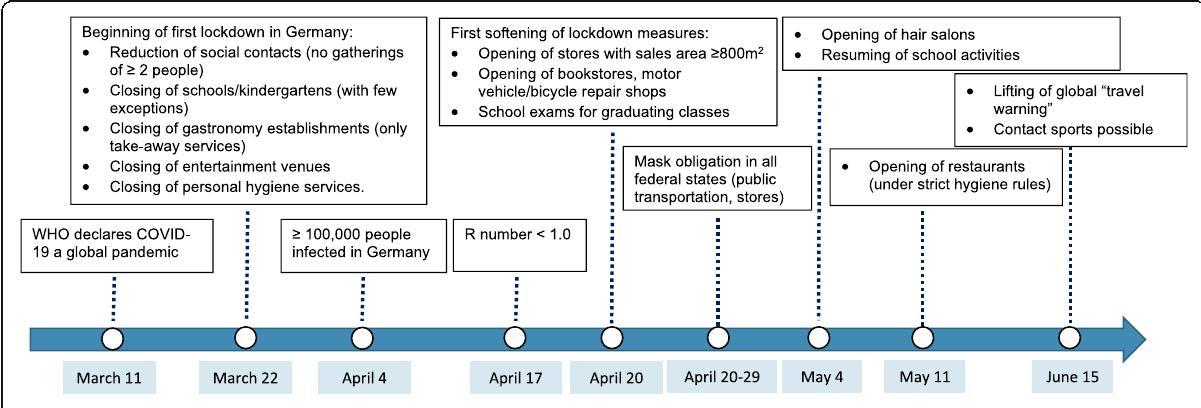
Fig. 1 Timeline of the first lockdown in Germany in